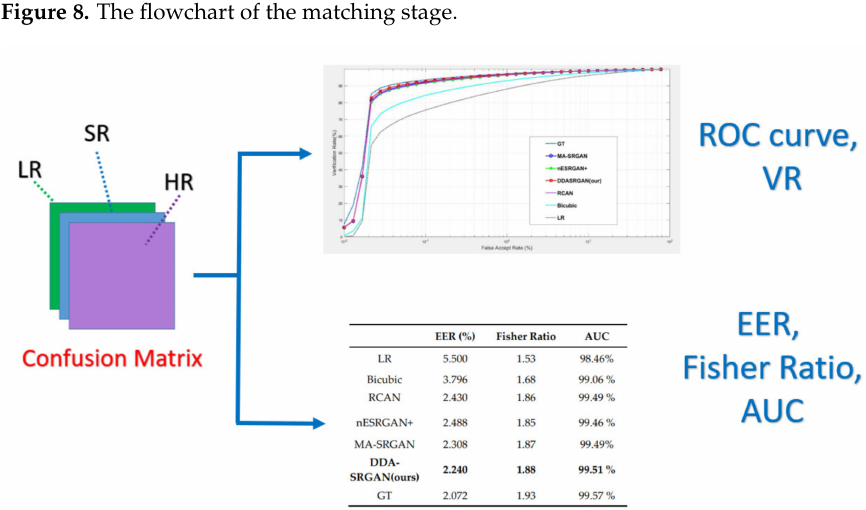
Figure 9. The flow chart of the performance evaluation